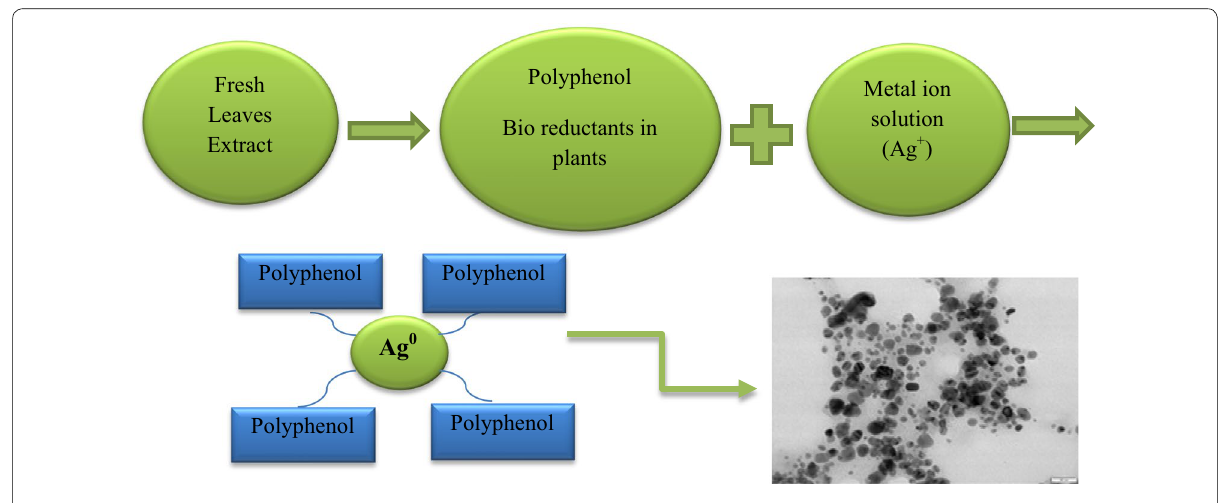
Fig. 1 Pattern of green synthesis. The chemical reaction of NPs synthesis includes several steps. Polyphenols convert positive Ag + into the zero Ag 0 valent metal, and in the last step of green synthesis the polyphenols coat metal NPs and affect the morphology and size of